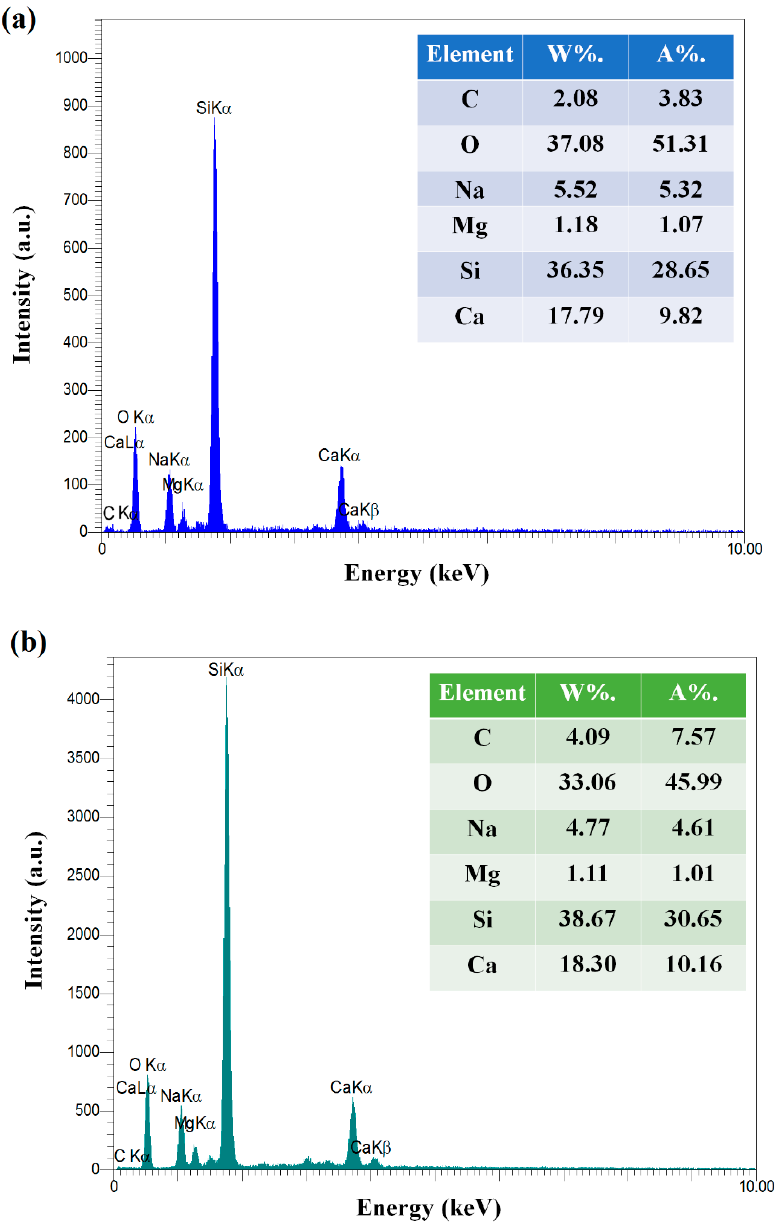
Figure 4. Energy-dispersive X-ray spectroscopy (EDX) spectra of ( a ) laboratory slide and ( b ) CNPs.